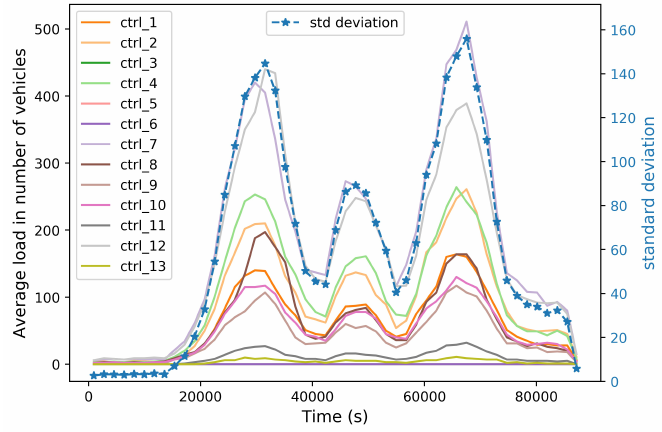
Figure 7. Average load per